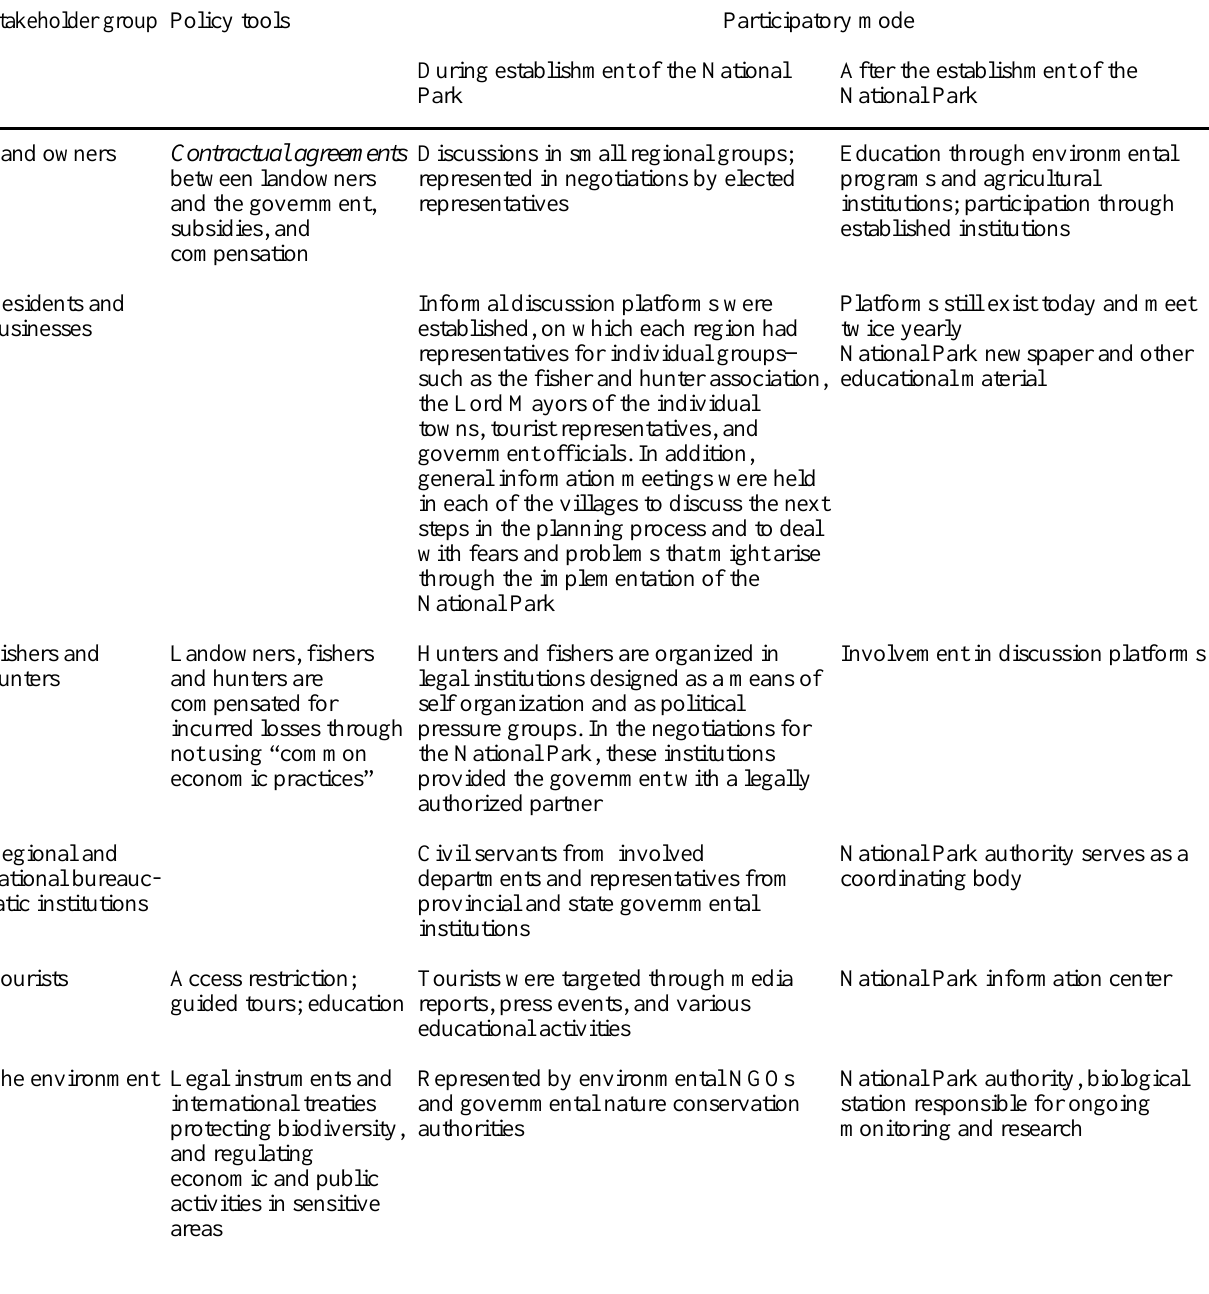
Table 5. Modes of involvement and policy tools in the National Park case study (note that individuals would fall into several